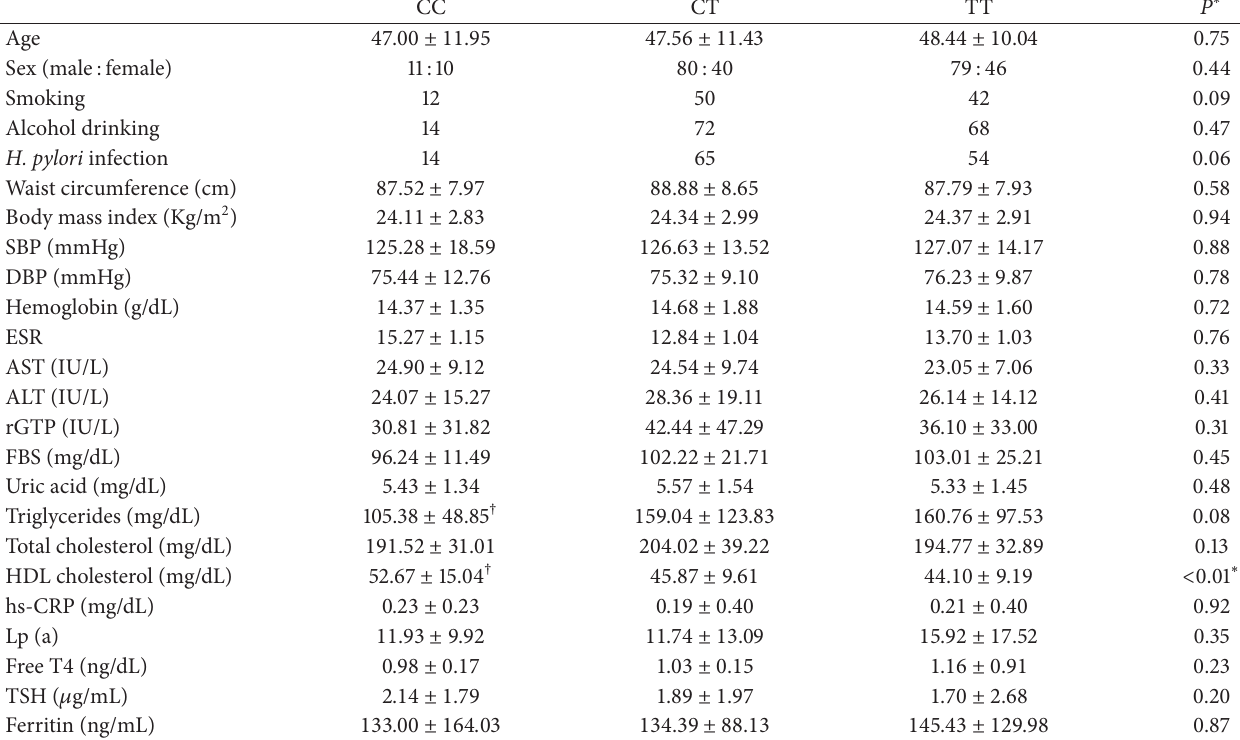
Table 1: Risk factors of atherosclerosis according to CD 14 − 159 genotypes.